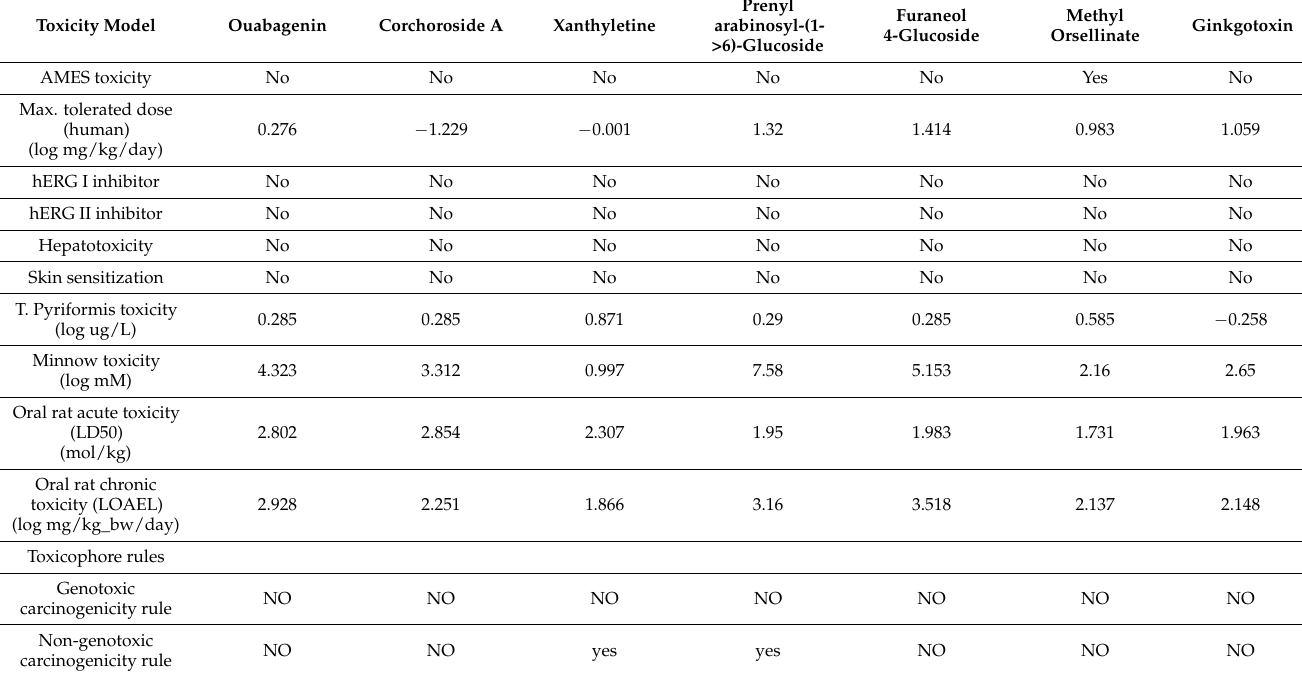
Table 6. Toxicity data for the screened metabolites using ADMETlab 2.0